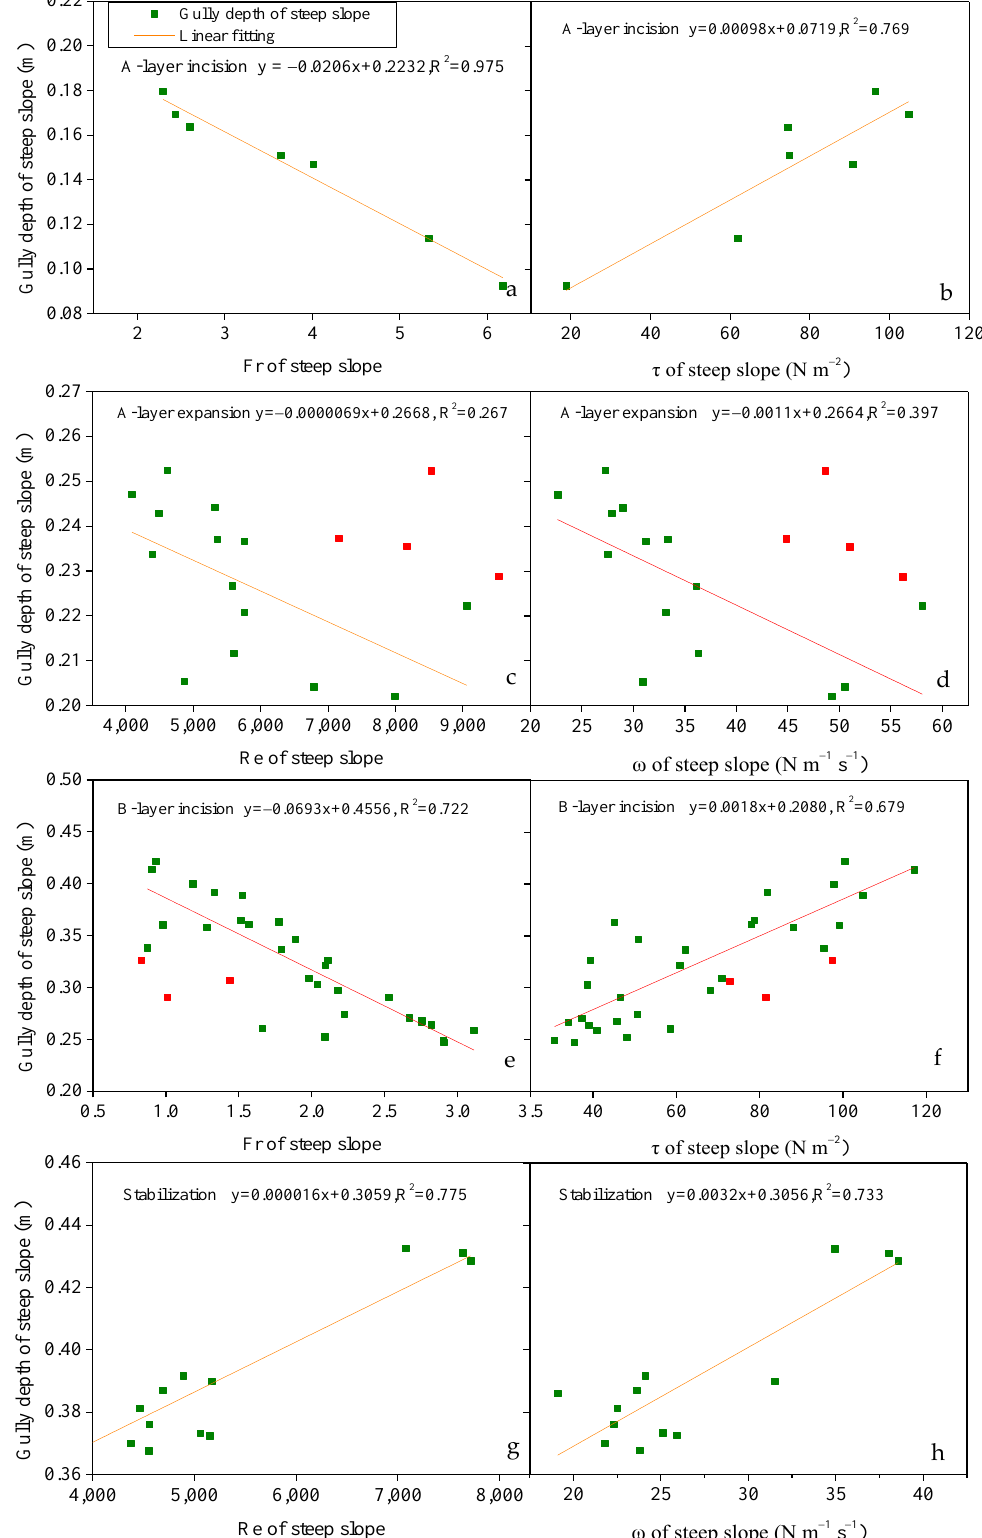
Figure 8. ( a , b , e , f ) are the linear fitting between SD and Fr and τ in the A-layer incision and B-layer incision; ( c , d , g , h ) are the linear fitting between SD and Re and ω in the A-layer expansion and stabilization. Note: The red point represents the abnormal point after sidewall